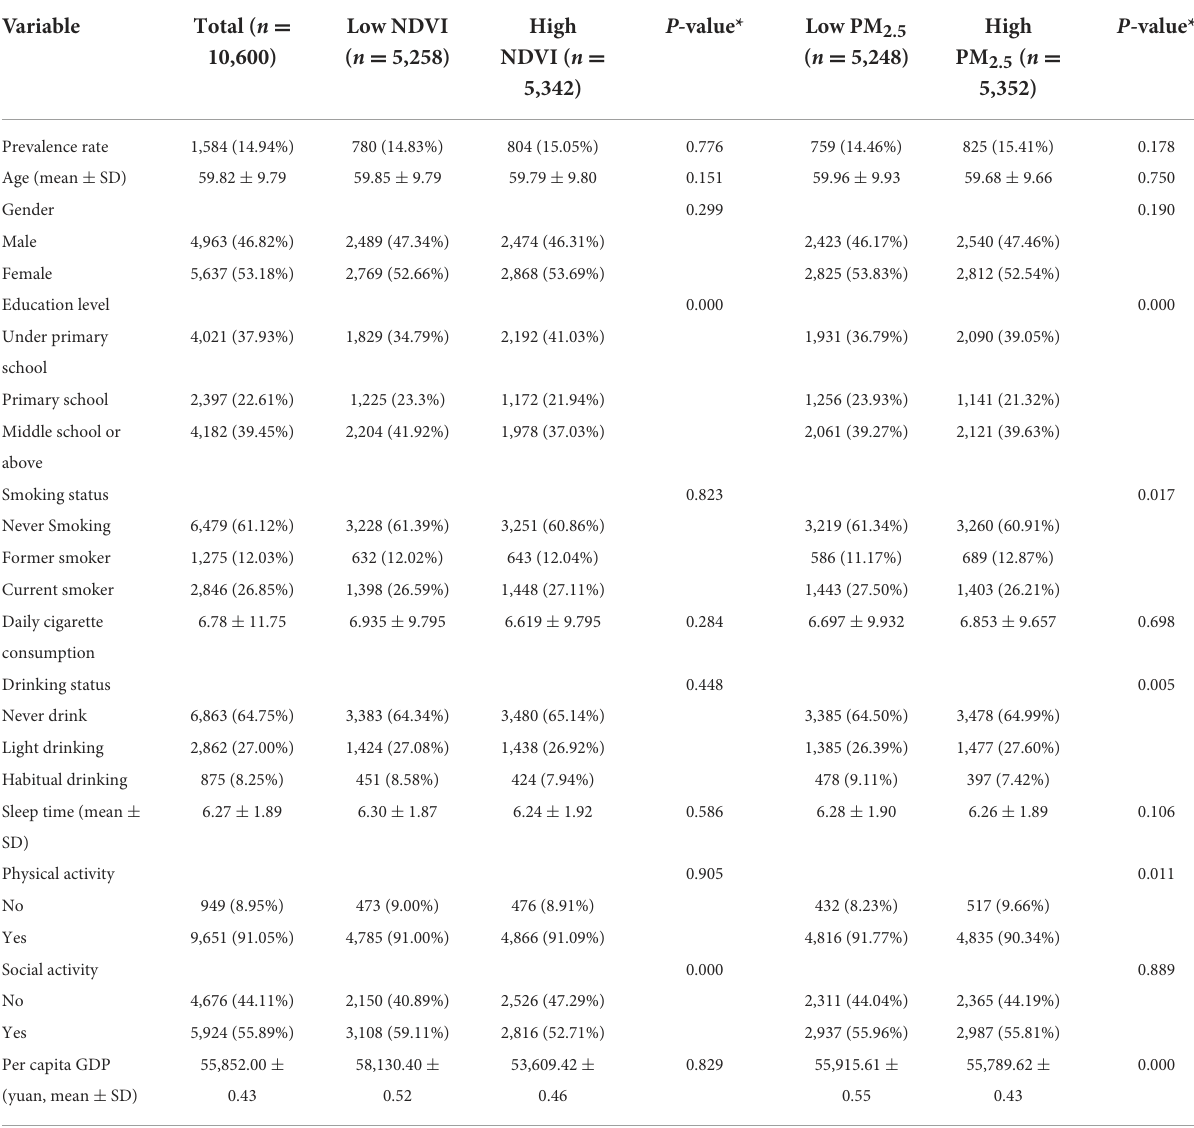
TABLE 1 Descriptive statistics of the study